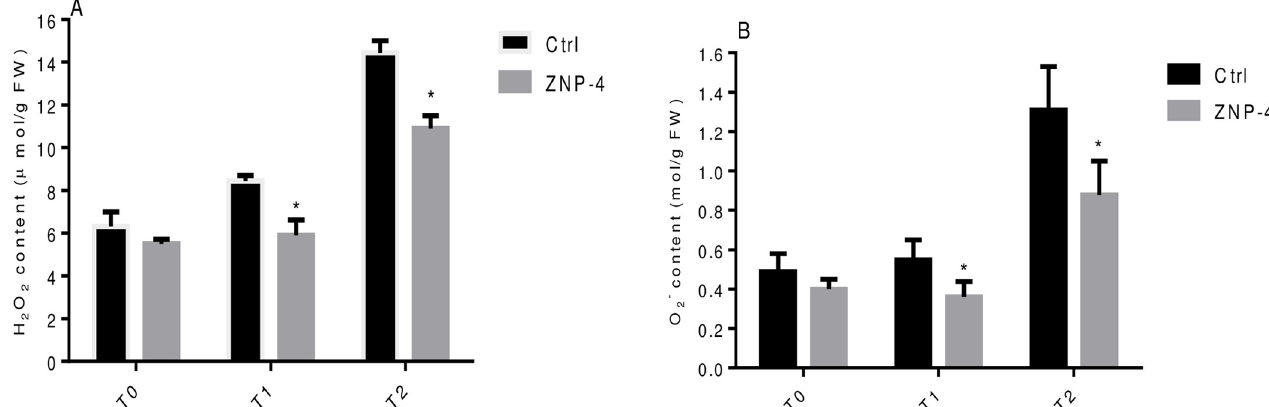
Fig 10. Effect of bacterium inoculation on H 2 O 2 and O 2- level under tested salinity stress (A) H 2 O 2 (B) O 2- content. � represent the significant difference as compared to respective control as per Ducan’s multiple range test (p = 0.05).